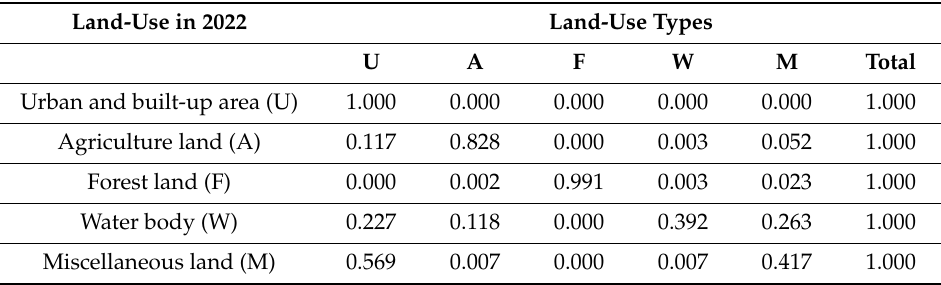
Table A10. Transition probability matrix for land-use change between 1986 and 1994. Land-Use in